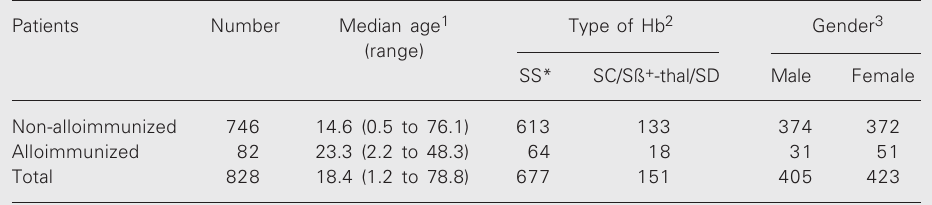
Table 2. Distribution of 828 patients with sickle cell disease according to median age, hemoglobin (Hb) phenotype, and